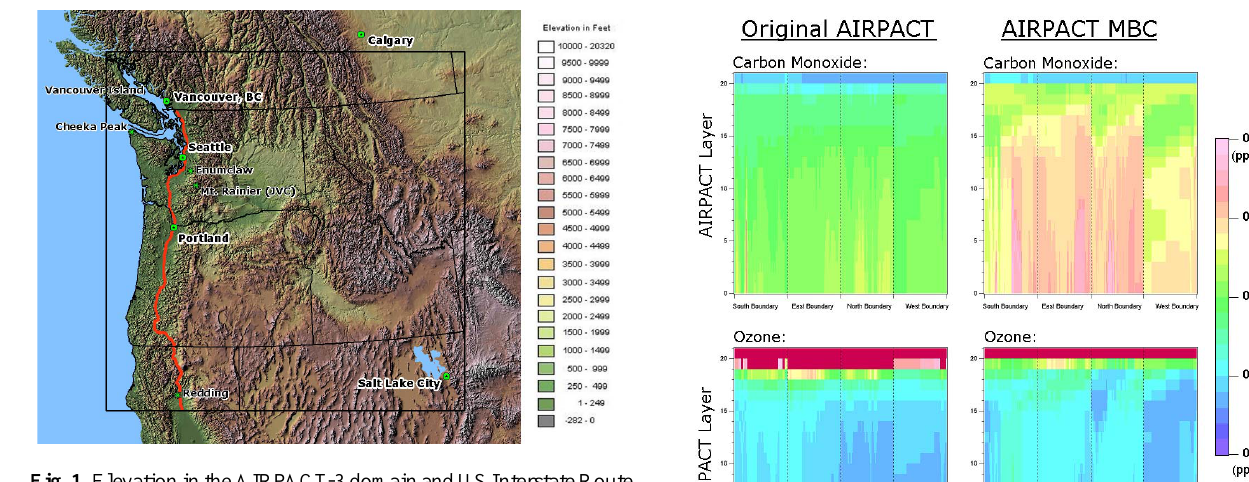
Fig. 1. Elevation in the AIRPACT-3 domain and US Interstate Route 5 drawn as orange line. The domain includes Washington, Idaho, and Oregon with partial inclusion of California, Nevada, Utah, Montana, Wyoming, British Columbia, and Alberta.